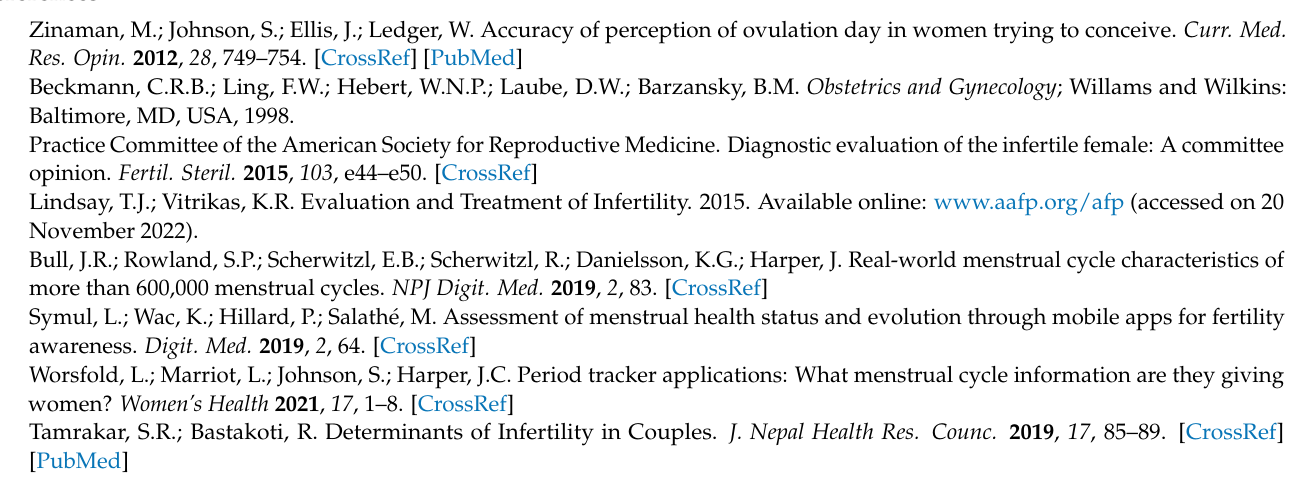
Table S1: Multi-Hormone strips show no cross-reactivity to tested compounds; Table S2: Diagnoses and